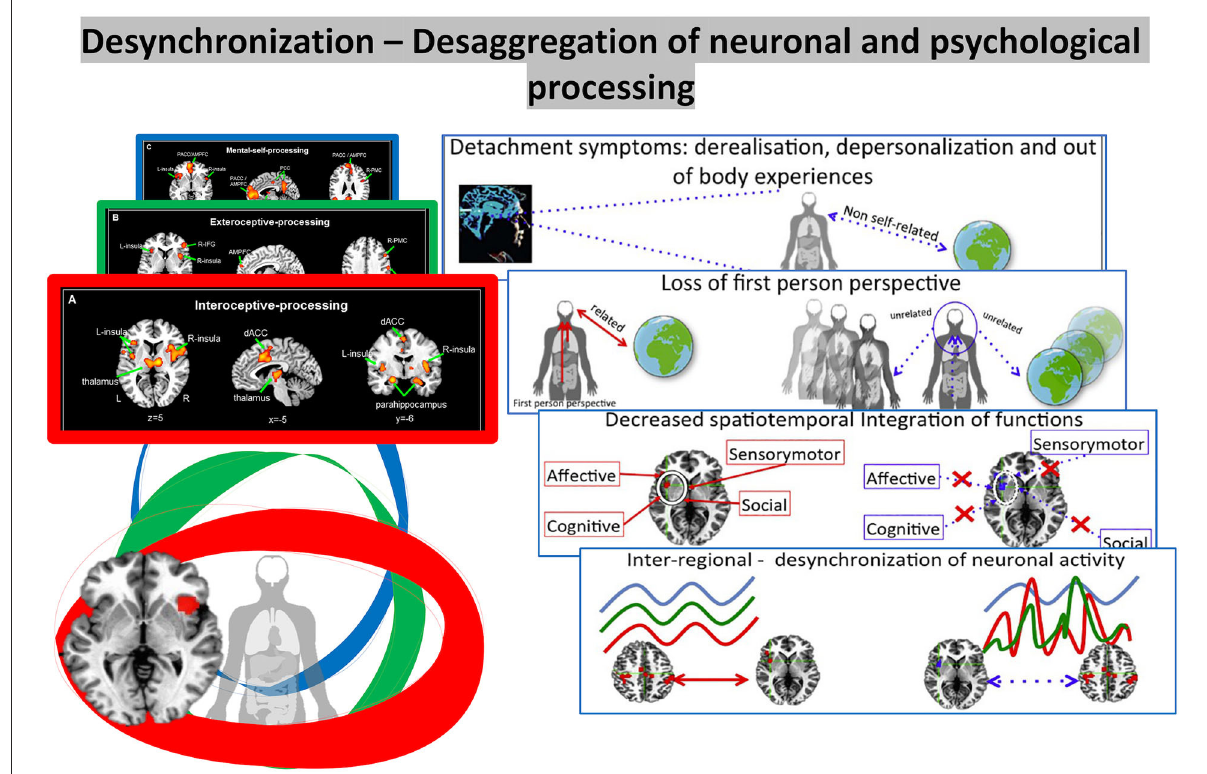
FIGURE9 Visual representation of dissociation and traumatic re-organization of nested hierarchy of